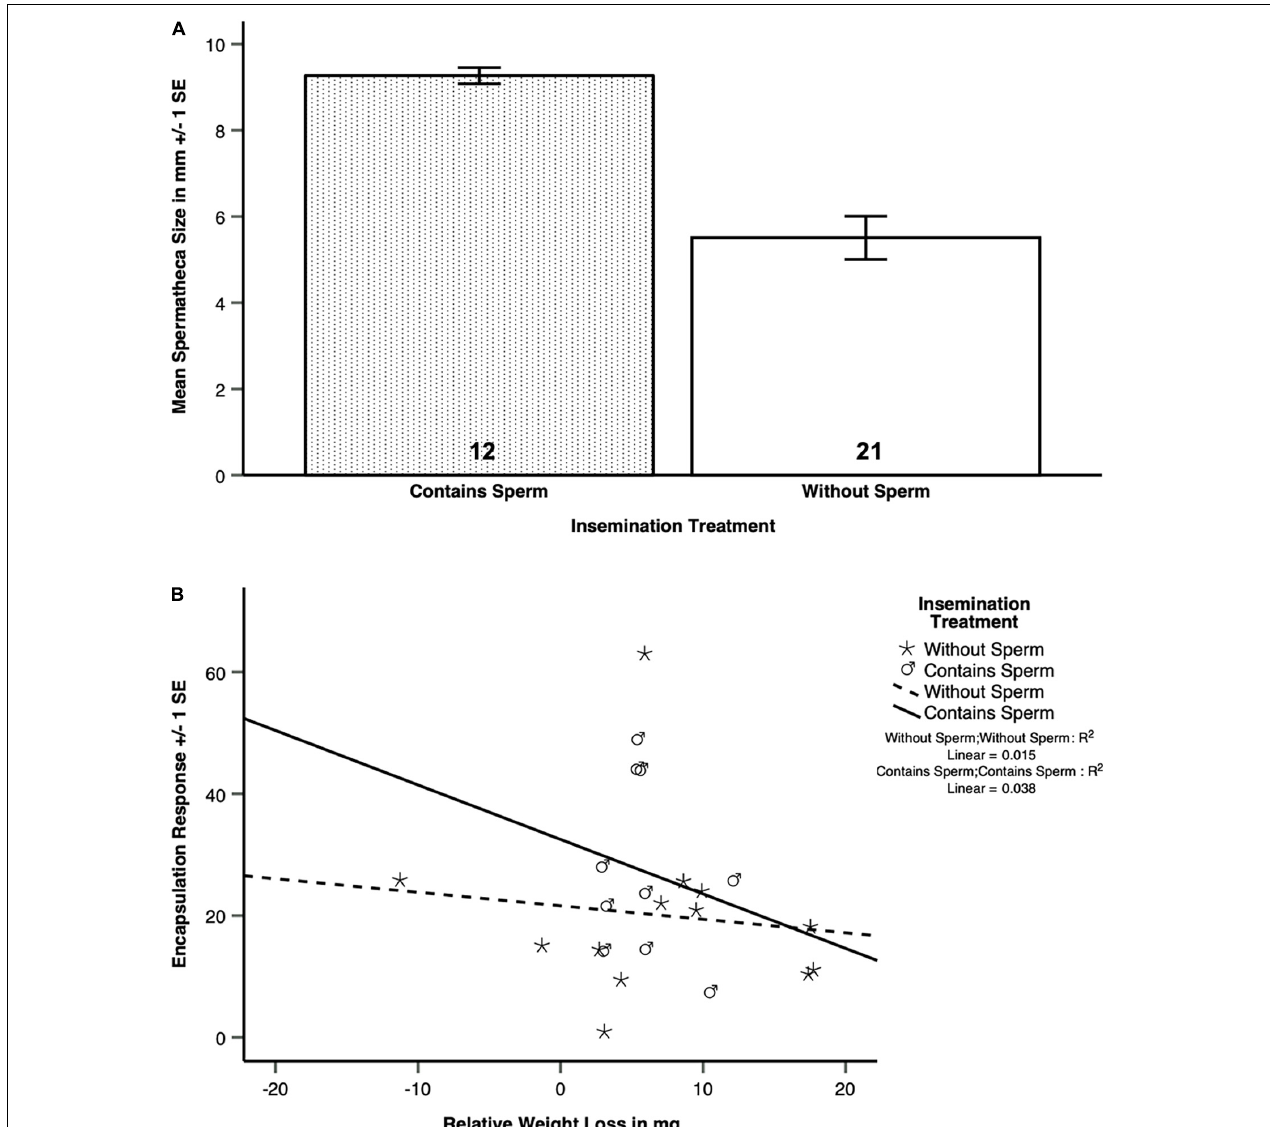
FIGURE 4 | (A) The spermathecal sizes of surviving Atta colombica queens after inseminations with full ejaculates or sperm only (pooled effects) were significantly larger than those of queens inseminated with Hayes saline solution or seminal fluid only ( Table 3B ). (B) Among the queens of Atta colombica that had survived an insemination treatment that involved sperm, those that had lost more weight had a significantly lower encapsulation response than those that had lost less weight. This interaction was not significant for survivors of treatments not involving sperm ( Table 2